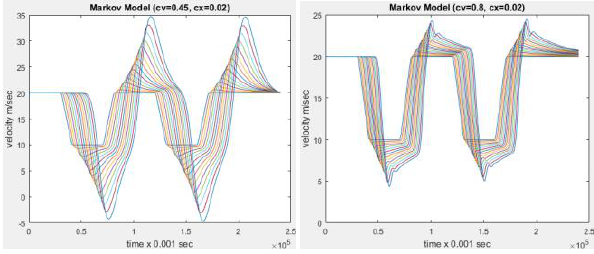
Fig. 19. The impact of the initial conditions on the velocity.